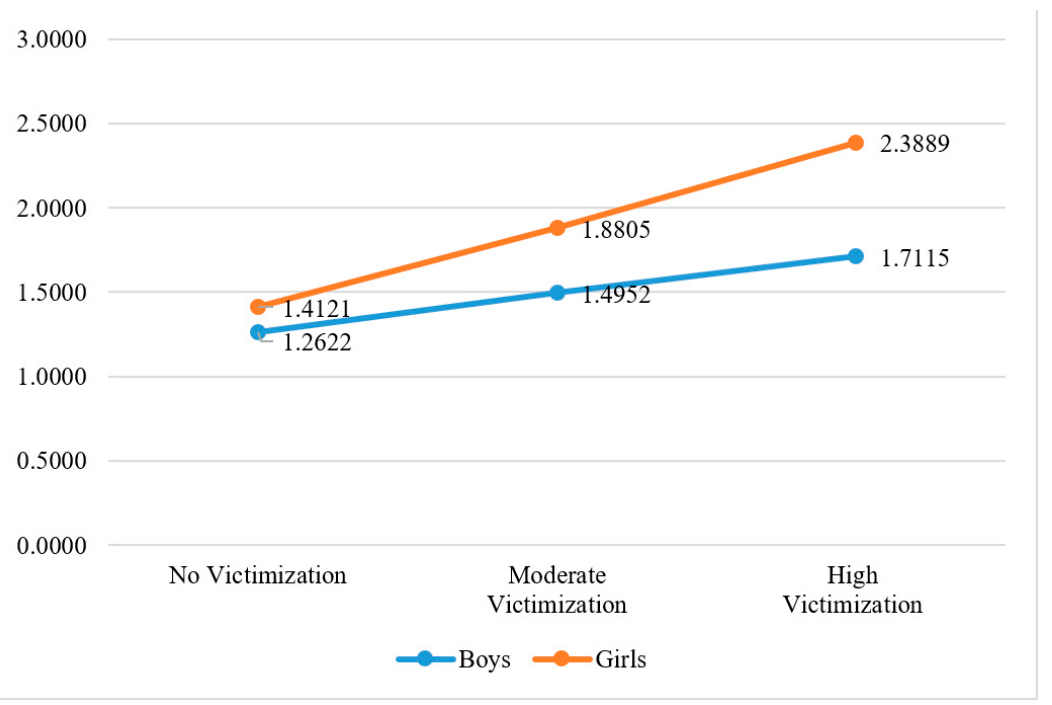
Figure 2. Marginal means of suicidal ideation and gender. Note: NV: no victimization, MV: mod- erate victimization, HV: high victimization. 4. Discussion Our results showed that Mexican boys are more victimized than girls in accordance with gender differences found in other countries [7,8,10]. The percentage of adolescents victimized was 29.85%, lower than the global estimation of 35.3% reported in a recent survey [6]. Interestingly, correlations confirmed that in early adolescence, social exclusion